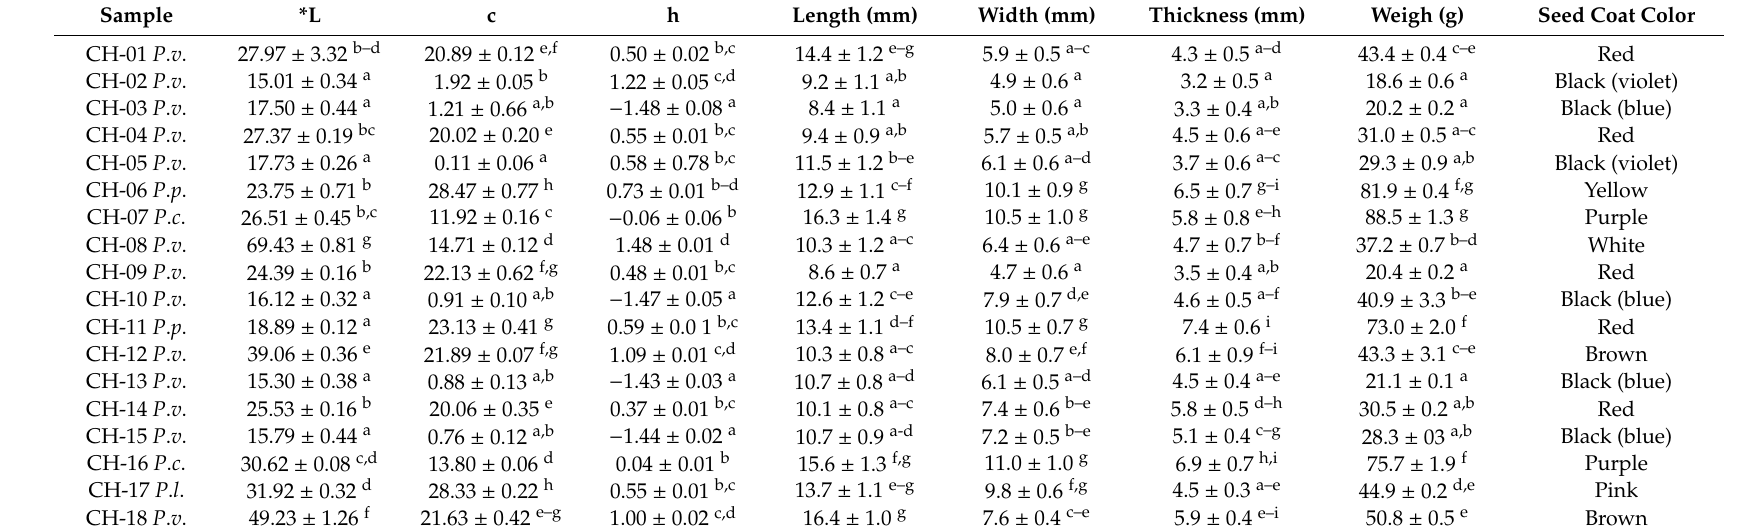
Table 1. Luminosity (*L), chromaticity (c), hue (h) of the grain beans and physical characteristics of the di ff erent species of Phaseolus